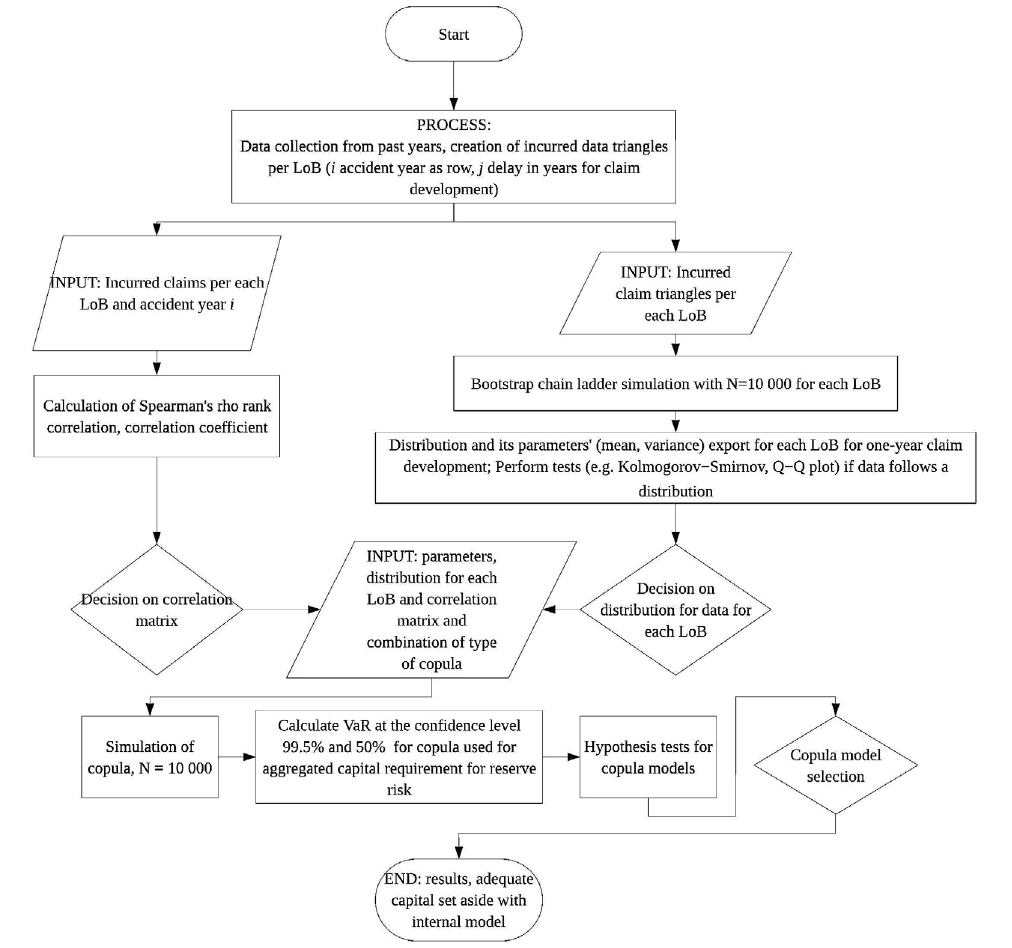
Fig. 3. Full algorithm steps of the internal model for reserve risk by aggregating various lines of business